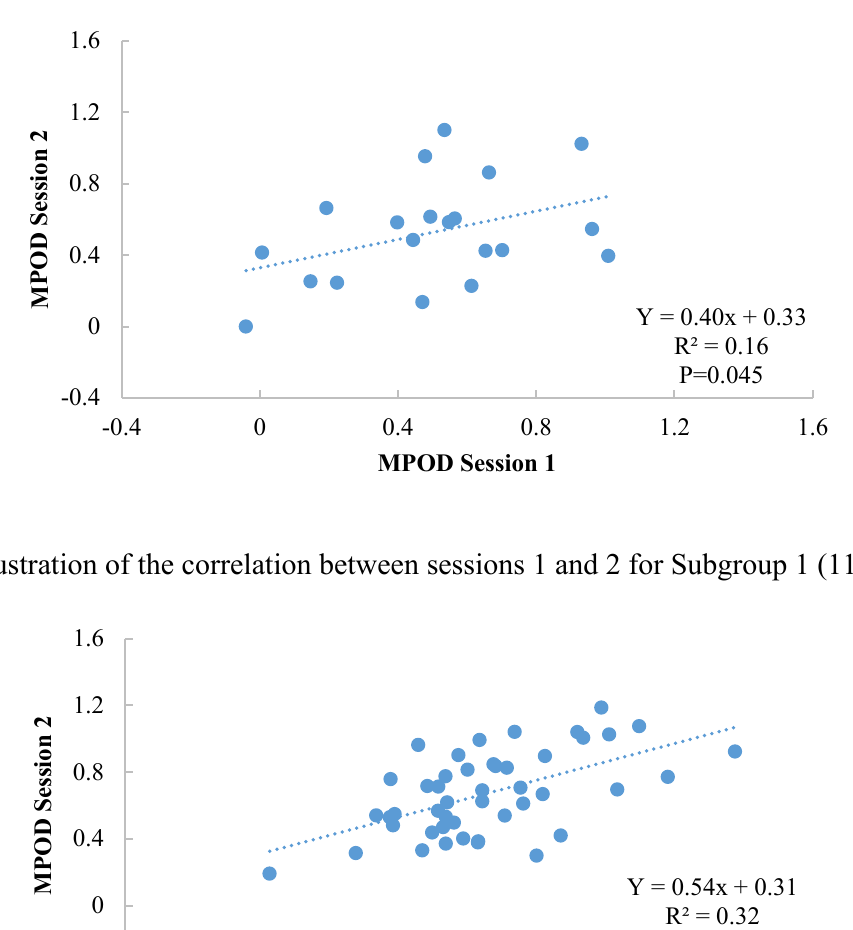
Figure 1. Illustration of the correlation between sessions 1 and 2 for the full sample ( n = 66).